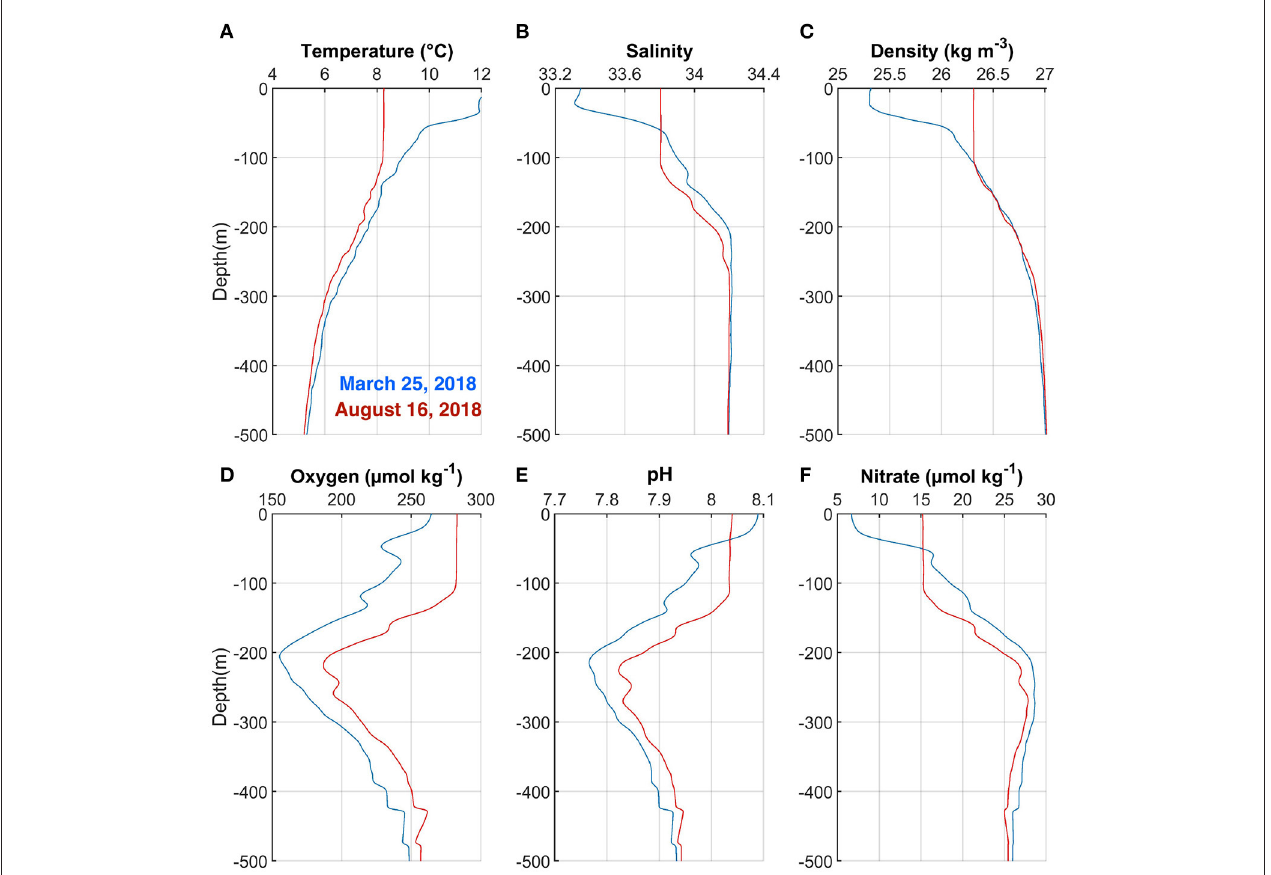
FIGURE 3 | Vertical profiles of (A) Temperature, (B) Salinity, (C) Potential density, (D) Oxygen, (E) pH, and (F) Nitrate on March 25 (blue curves) and August 16 (red curves), 2018 (see Figure 1 ).